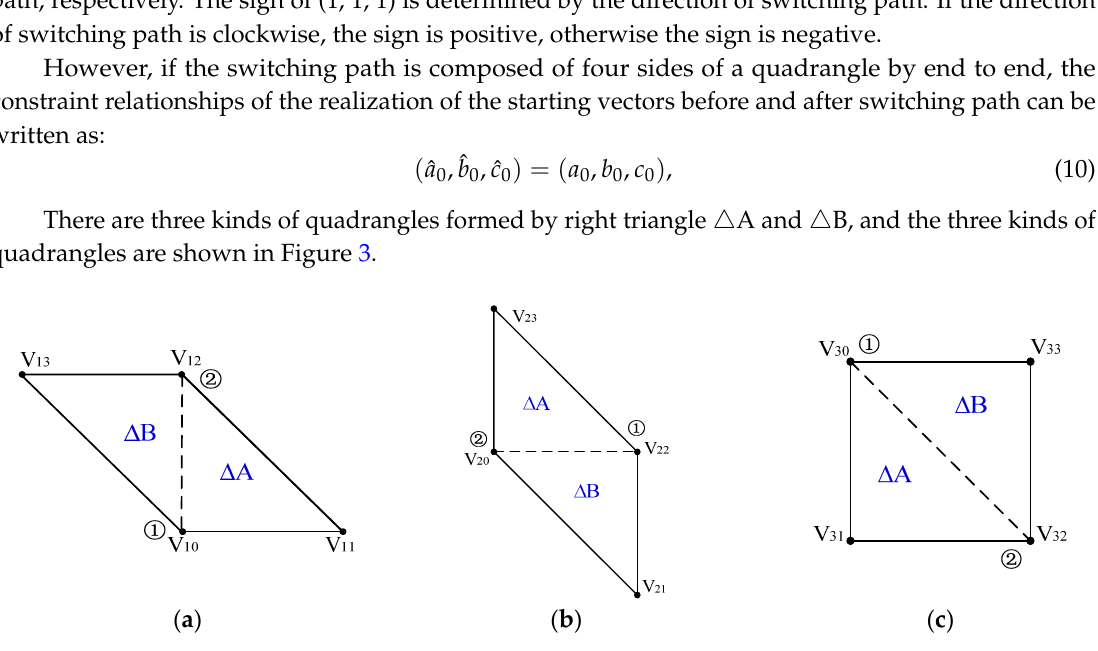
Figure 3. Three kinds of quadrangles, ( a ) the first kind; ( b ) the second kind; ( c ) the third